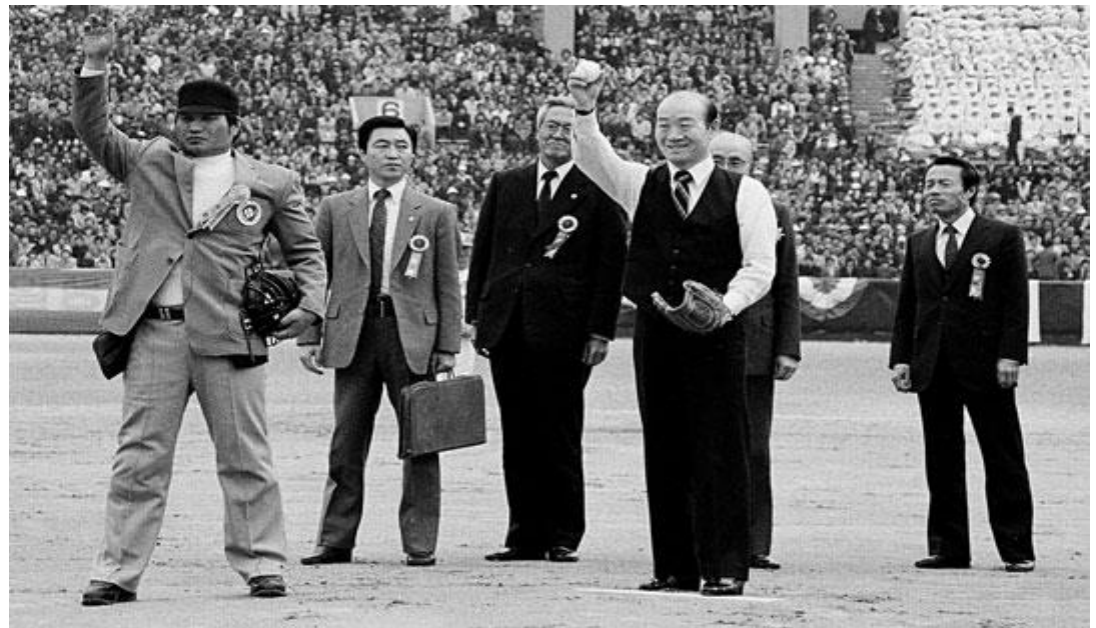
Figure 3. President Chun Doo-Hwan’s first pitch in the professional baseball opening game in 27 March 1982, Data source: real time news media, https://m.ilyo.co.kr/?ac=article_view&entry_id=120011, (accessed on 22 January 2021).